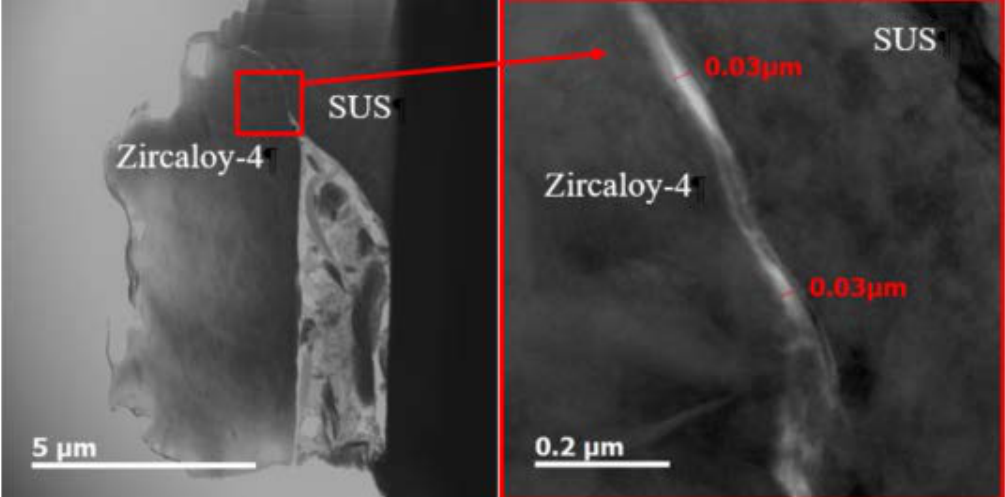
Figure 11. Cross-sectional transmission electron microscopy (TEM) image showing the interfacial structure of the Zircaloy-4/SUS 316 PST quenched to room temperature after being maintained at 900 °C for 1 h.